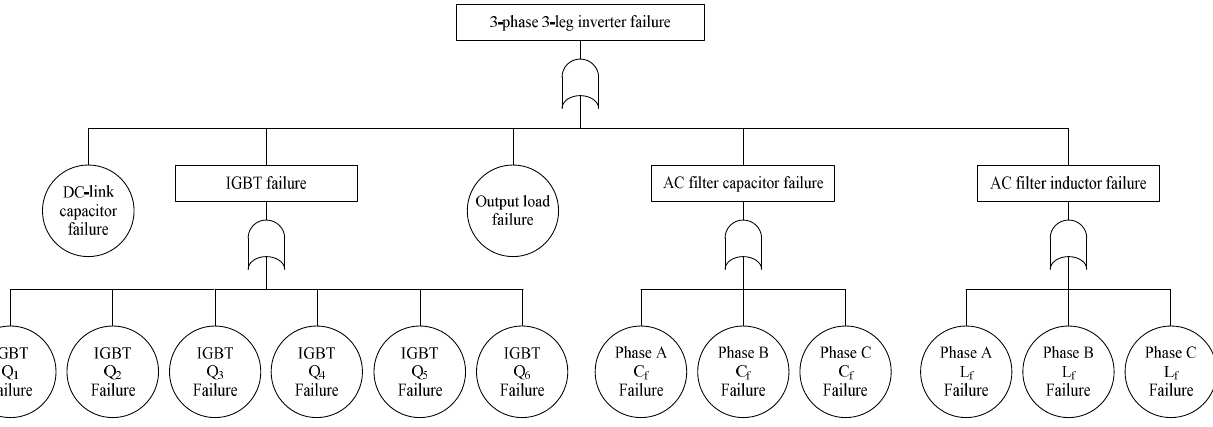
Figure 5. Failure dependency of three-phase 3-leg inverter.